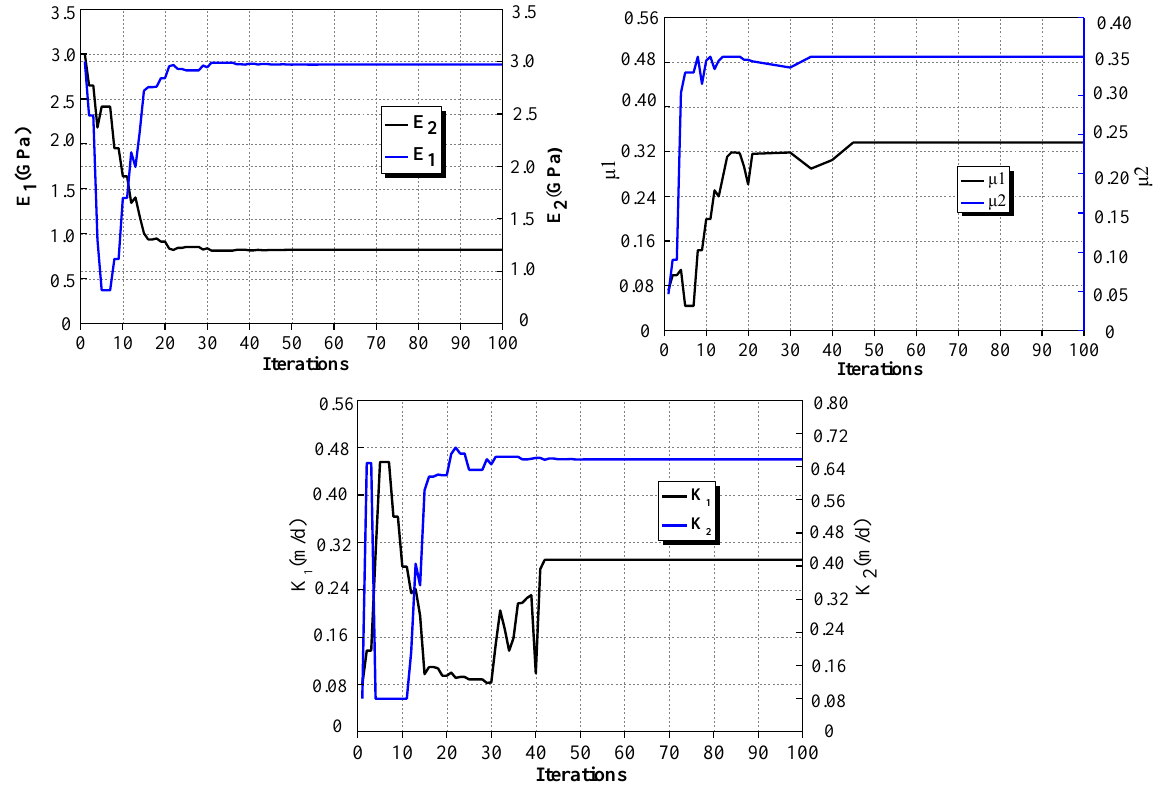
Figure 5. Variation in the recognized parameters.